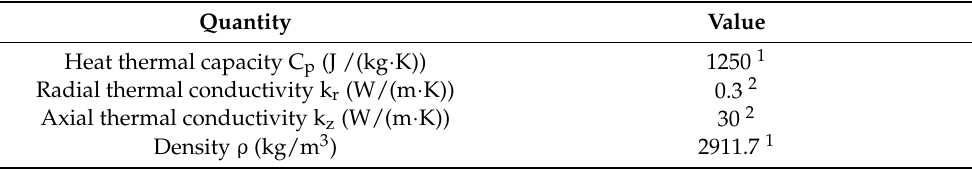
Table 2. Physical parameters for cell